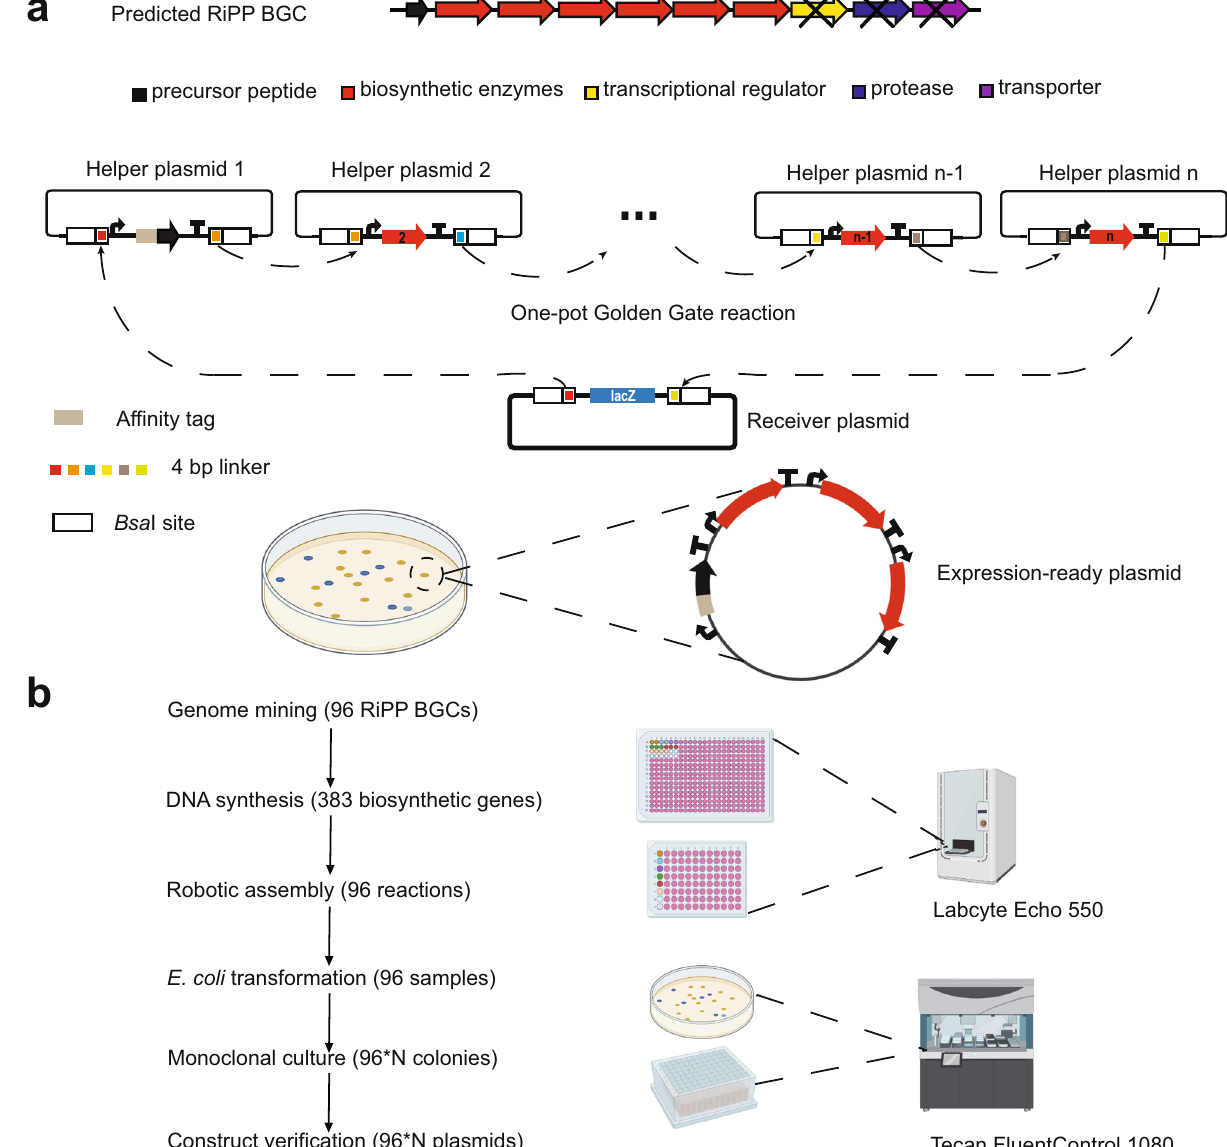
Fig. 2 | Design of high-throughput pathway refactoring. a Refactoring scheme for a representative RiPP BGC using Golden Gate assembly. Genes involved in transcriptional regulation, leader peptide removal, and cellular export were omit- ted from refactoring. The codon-optimized gene encoding the precursor peptide was inserted into helper plasmid 1 with an N-terminal His 6 -tag and other genes encoding biosynthetic enzymes were inserted into the following helper plasmids. Each helper plasmid contained two Bsa I recognition sites fl anking the insert, fol- lowed by a unique pair of 4-bp linkers, a T7 promoter, and a T7 terminator. The constructedcassettesthatcompriseofagenedrivenbyaT7promoterinthehelper